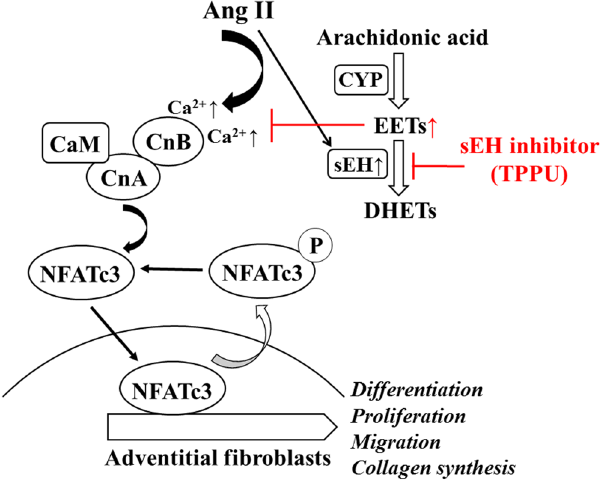
Figure 6. Schematic of the potential mechanisms of sEH inhibition on Ang II-induced adventitial